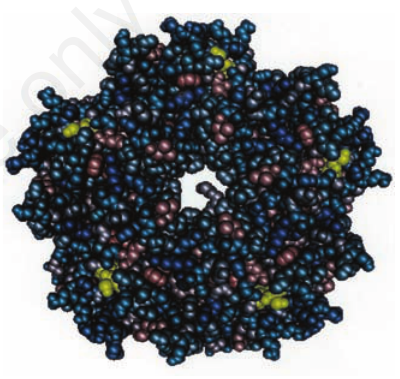
Figure 1. The sequence allignment (red displaying the DSP sequence) shows portions of the initial segment of amino acids for the following VP1 coat protein for polyoma virus- es, in descending order from top down: Mouse polyomavirus (strain p16 small-plaque), Simian virus 40,Kilham polyomavirus, Budgerigar fledgling disease, polyomavirus